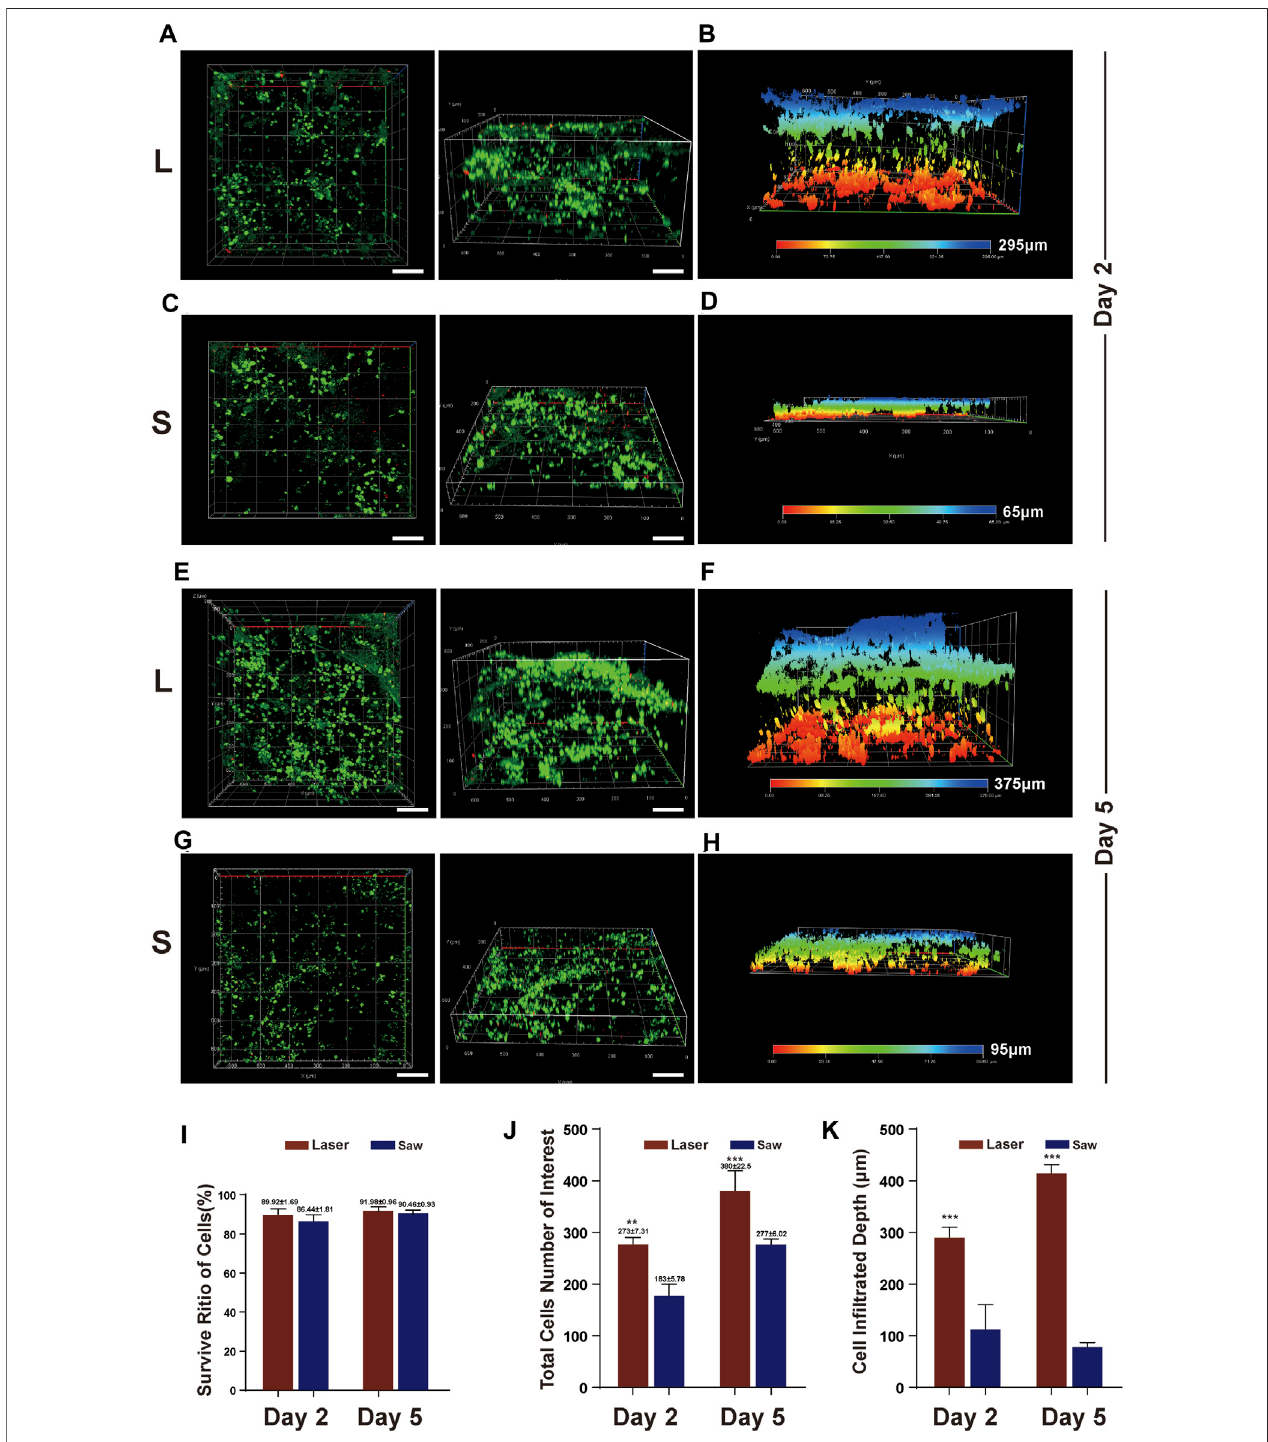
FIGURE 6 | MSC in fi ltration into bone surface. (A) Typical images of z-axis reconstruction of adhesive MSCs on bone slices at Day 2 after the cell inoculation (culture)inLgroup, (B) in fi ltrationdepthatDay2afterthecellinoculationinLgroup. (C) Typicalimagesofz-axisreconstructionofadhesiveMSCsonboneslicesatDay2 after the cell inoculation in S group, (D) in fi ltration depth at Day 2 after the cell inoculation in S group. (E&G) Typical images at Day 5 after the cell inoculation in the two groups. live = green, red =dead and scale bar = 100 μ m. (F&H) in fi ltration depth at Day 2 after the cell inoculation in the two groups. (I) Quanti fi cation of viable cell percentagein fi ve scopesinLand Sgroup. (J) Quanti fi cation oftotalnumber ofMSCsin fi vescopesinL and Sgroup. (K) Quanti fi cation ofMSCsin fi ltration depthin fi ve scopes in L and S group. **, p < 0.01, ***, p < 0.001.